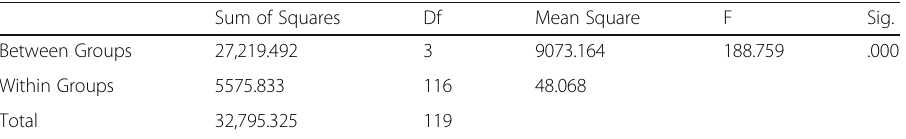
Table 7 One-Way ANOVA; Post-test Autonomy Sum of Squares Df Mean Square F Sig. Between Groups 27,219.492 3 9073.164 188.759 .000 Within Groups 5575.833 116 48.068 Total 32,795.325